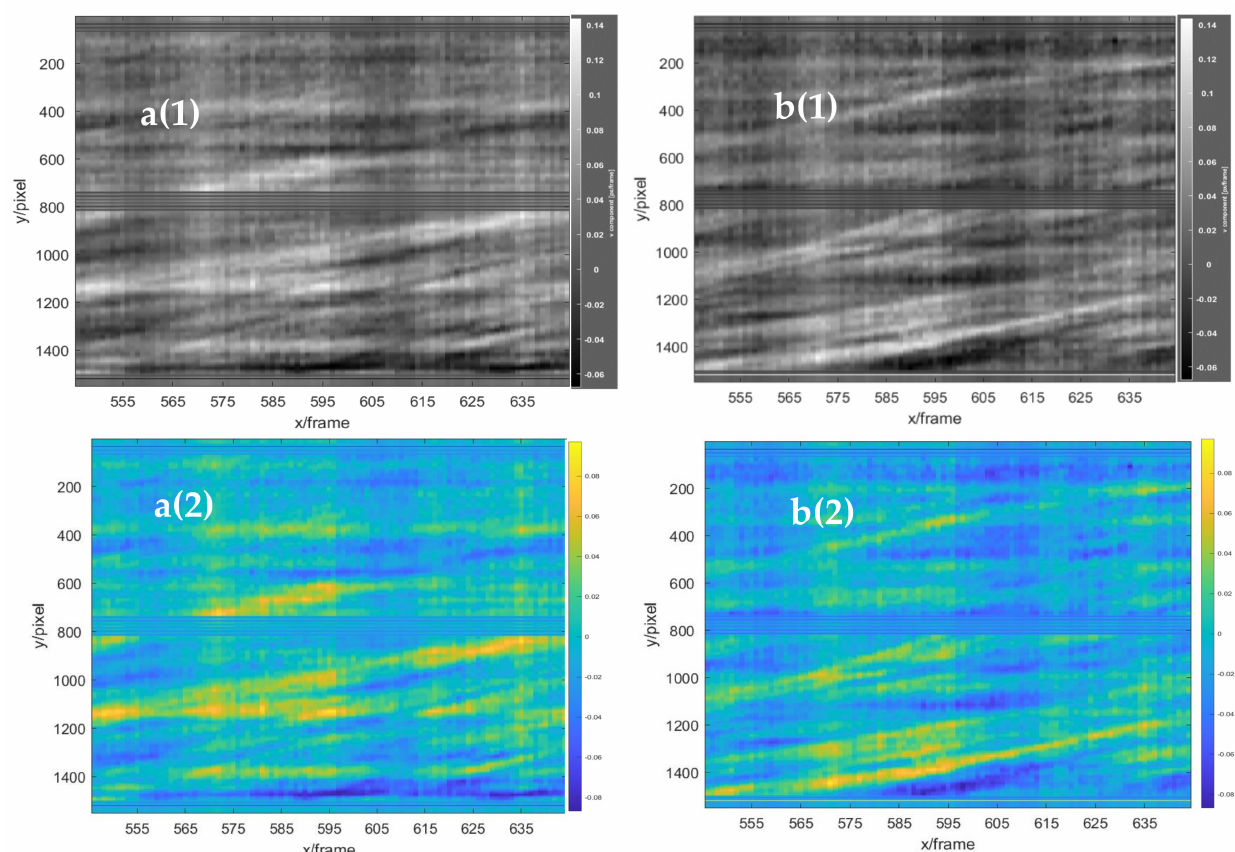
Figure 21. The stacked baseline analysis graphs in the vertical direction of 100 frames. a ( 1 ) Baseline a (gray scale), and a ( 2 ) baseline a (RGB color). b ( 1 ) Baseline b (gray scale), and b ( 2 ) baseline b (RGB